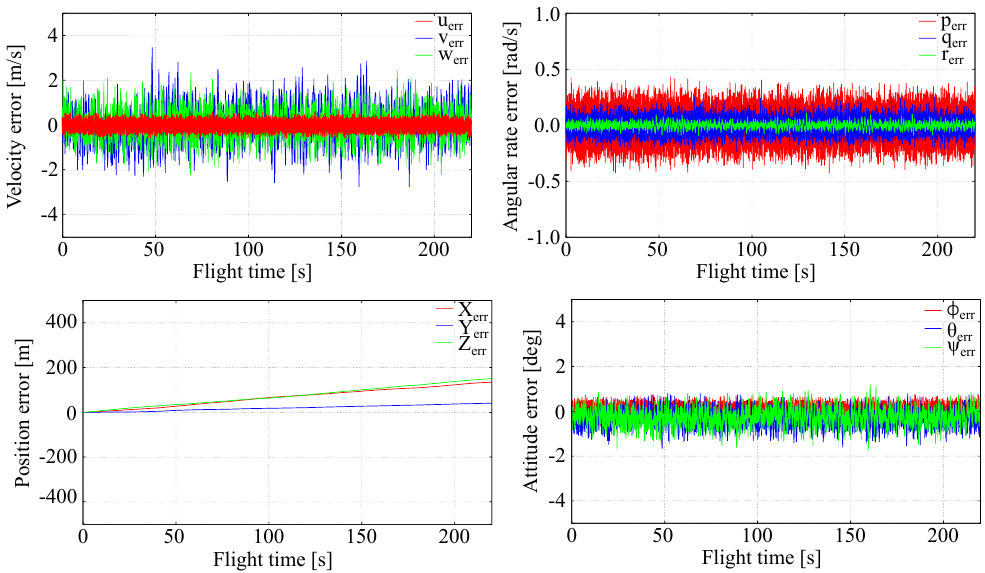
Figure 9. Full tracking errors—flight parameters disturbed by 1 unit (Case 1).